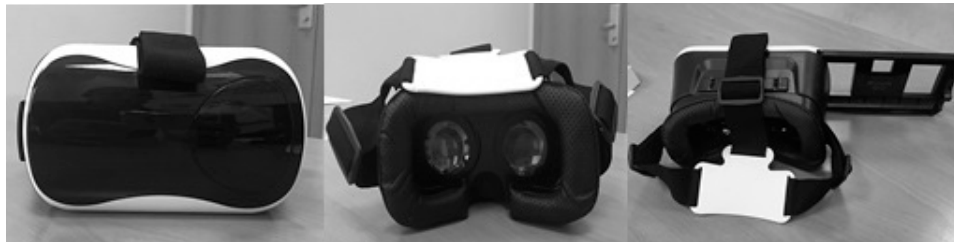
Figure 1. VR Vox Play virtual reality glasses.